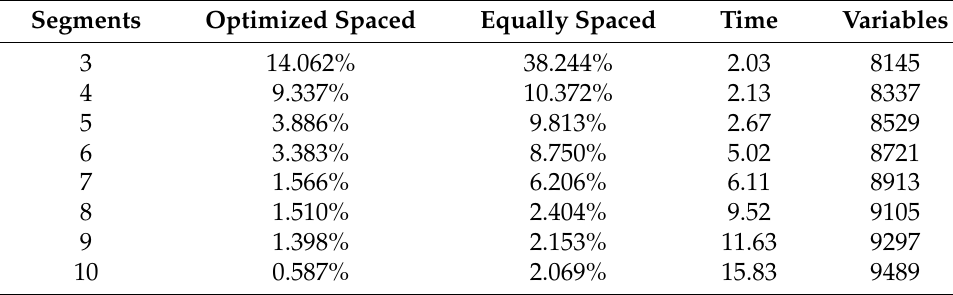
Table 6. Comparison of results for different numbers of